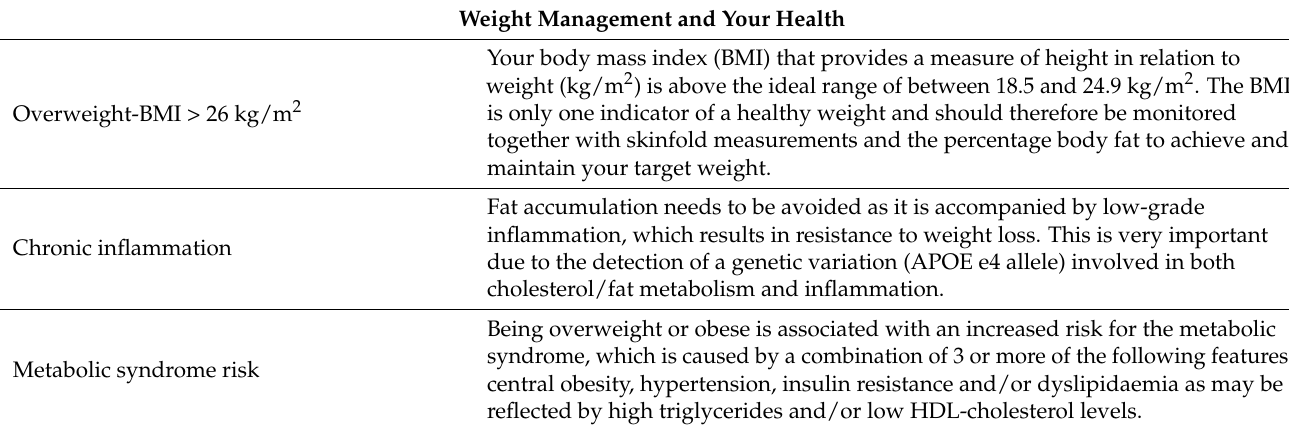
Table 1. Interpretative commenting on the pathology-supported genetic testing performed (April 2011) in the symptomatic COVID-19 reinfected patient based on self-data reporting (July 2021) for clinical follow-up by the treating physician. Weight Management and Your Health